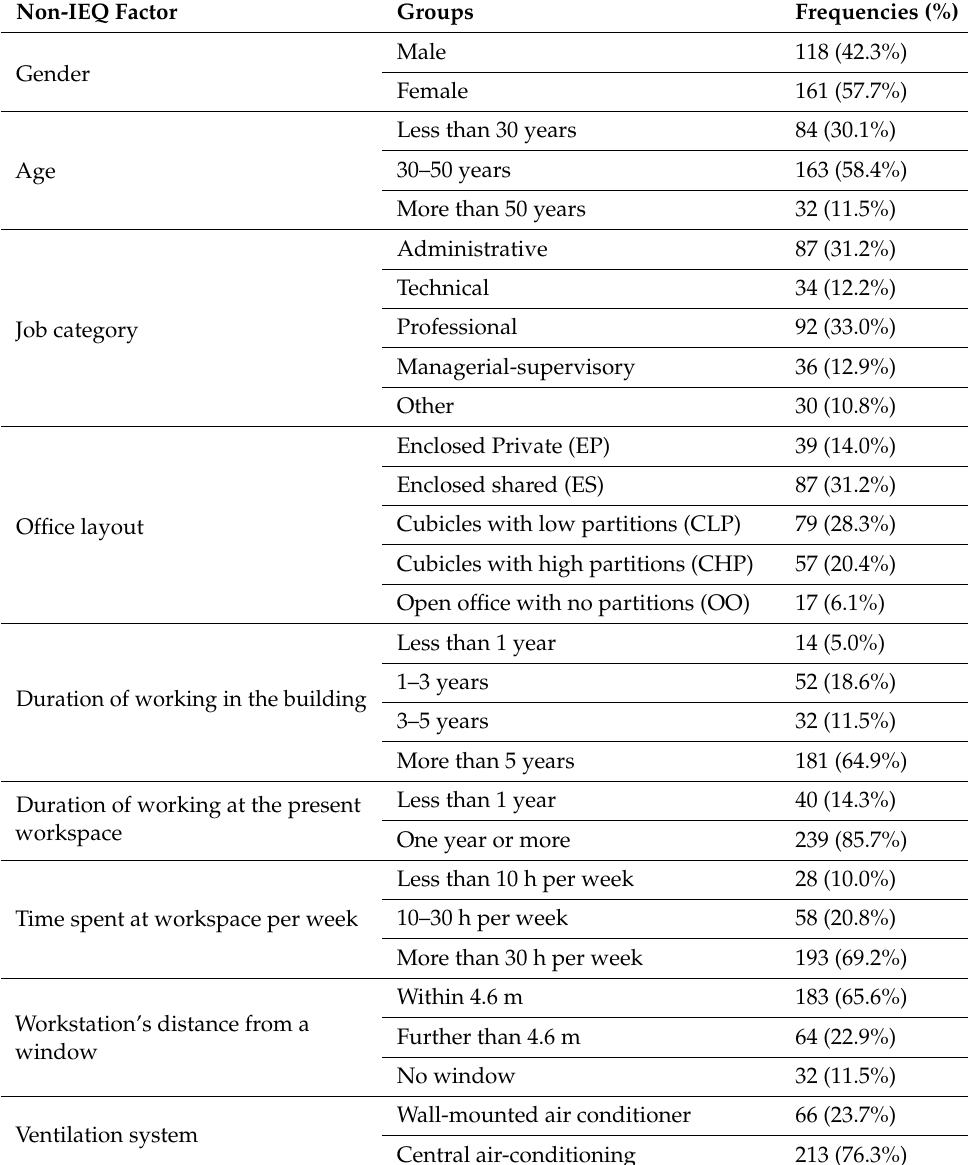
Table 2. Occupants’ characteristics and building attributes (non-IEQ